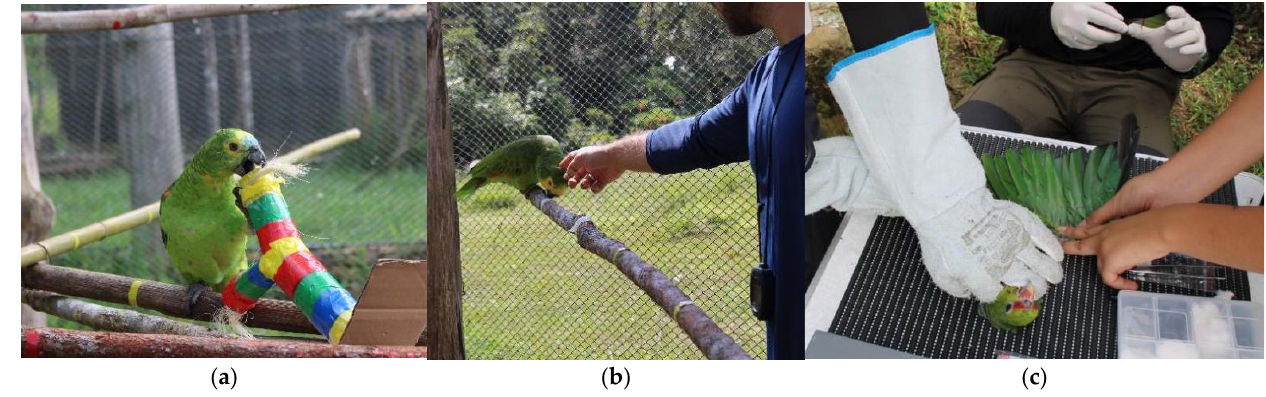
Figure 1. ( a ) Interaction between the parrot and the colored stick used as a novel object in the first novel object test; ( b ) flight distance measurement performed after the unknown person reaction test; ( c ) manual restraint test: blood collection for parasitological exams in which behavioral variables were recorded during physical